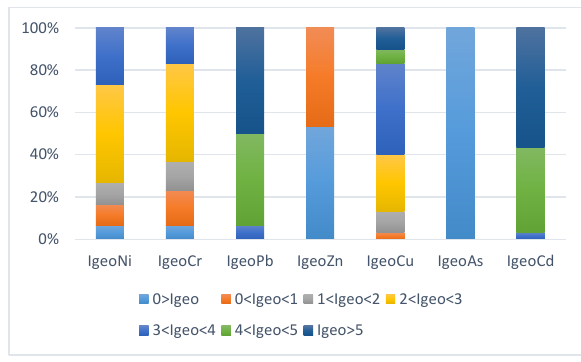
Figure 3. Geo-accumulation Index (Igeo) at Stations Understudy Table 8 presents the calculation and descriptive statistics and the number of samples investigation of pollution level for NIPI of toxic for pollution index classification. The results of elements at 30 studied stations in terms of the NIPI index showed that 100% of surface